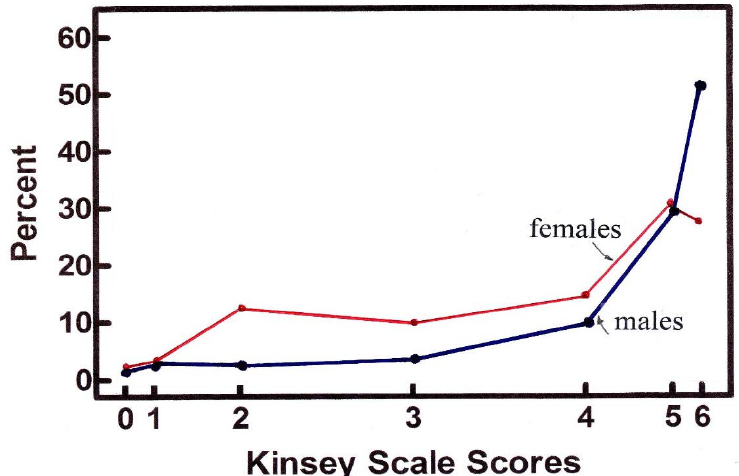
Figure 1. Kinsey Scale Score Profile (Attraction): Males and Females. Table 1. Sexuality Measures in the LGBTQ LDS Sample.